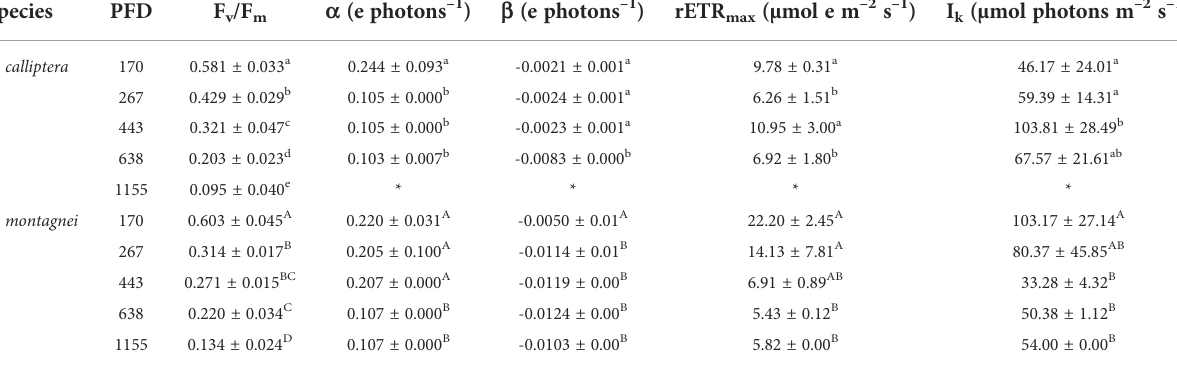
TABLE 1 Maximum quantum yield (F v /F m ) and photosynthetic parameters of the relative electron transport rate vs. photon fl uence rate curves of Bostrychia calliptera and B. montagnei cultured under different photon fl ux densities (PFDs in µmol photons m – 2 s – 1 ) for 14